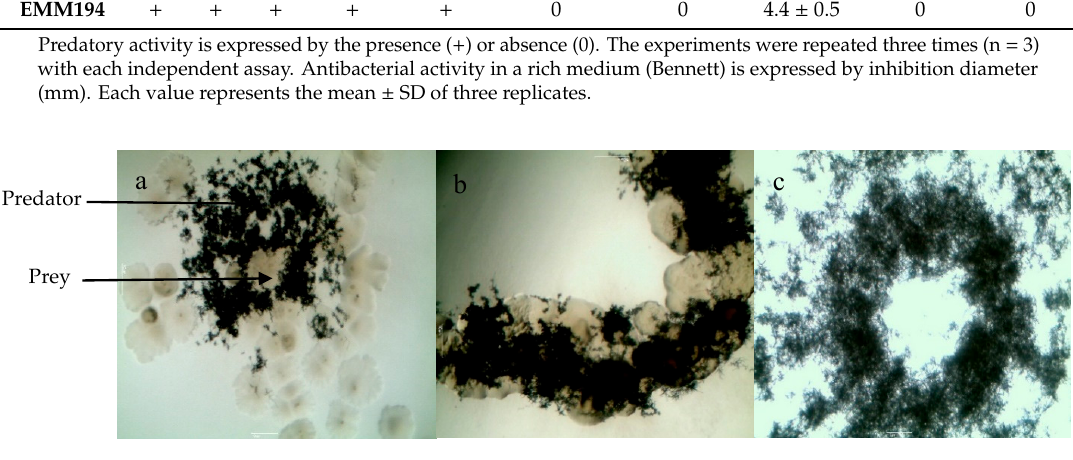
Table 2. Comparison of the predatory activity and the antibacterial activity on rich medium of four predatory Actinobacteria isolates.